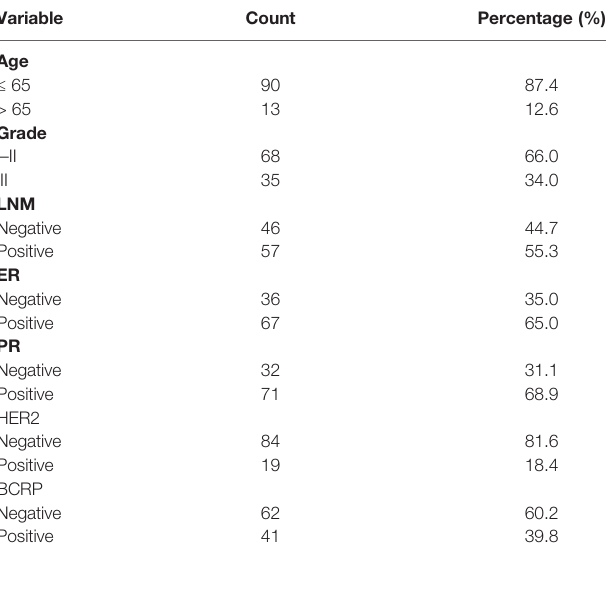
TABLE 1 | Clinicopathological characteristics of 103 patients with follow up in the present study. Variable